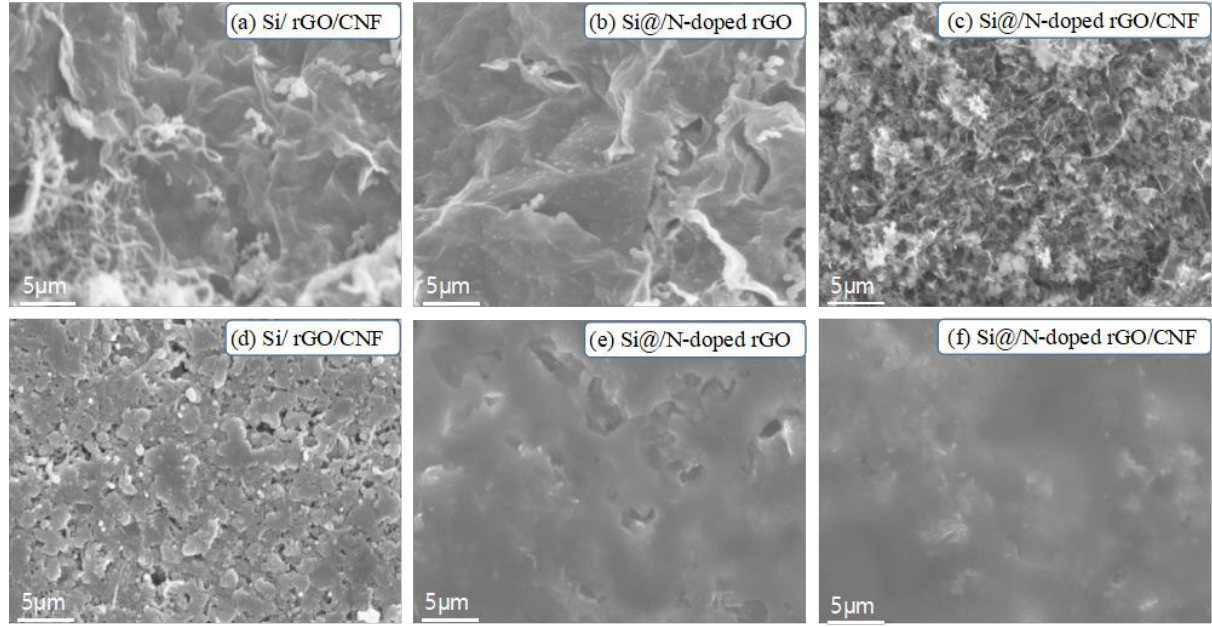
Figure 9. ( a – c ) SEM images of the surface of Si/rGO/CNF, Si@/N-doped rGO, and Si@/N-doped rGO/CNF electrodes before the first cycle, ( d – f ) SEM images of the surface of Si/rGO/CNF, Si@/N-doped rGO, and Si@/N-doped rGO/CNF electrodes after the 100th cycle at a current density of 0.1 Ag −1 .